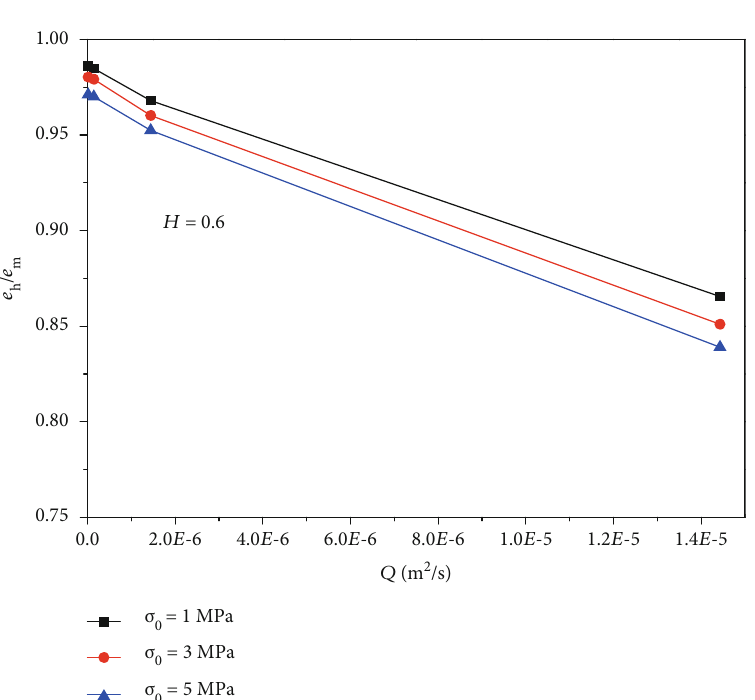
/ e varies with fl ow rate with H = 0 : 55 . h m